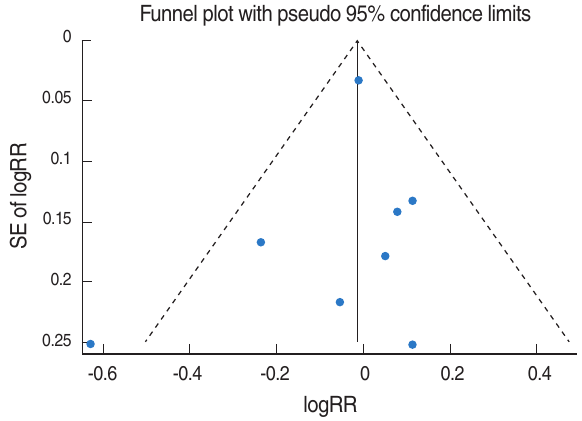
Figure 4. A funnel plot using fixed-effects summary estimates in 8 cohort articles evaluating the association between intake of citrus fruits and pancreatic cancer risk. logRR, log relative risk; SE of logRR, standard error of log relative